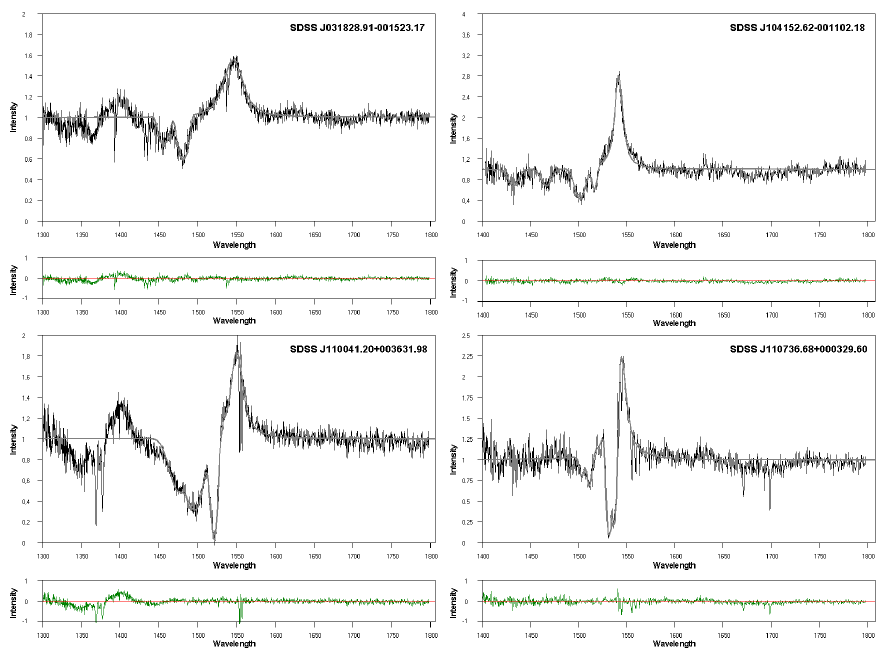
Fig. 1. Four examples of the fitted spectra. Black lines show the observed spectra and grey lines – theoretical line profiles given by the GR model. The lower panels show differences between the observed spectra and the corresponding theoretical